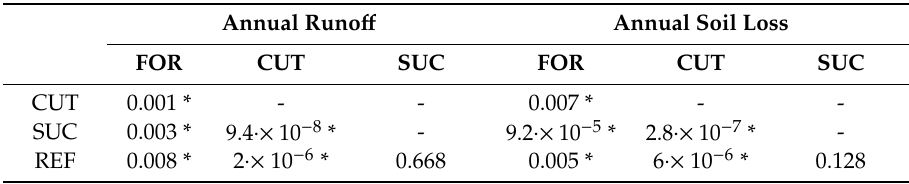
Table 12. U-test p -values for standardized annual modeling results, (FOR)ested, (CUT)-down, (SUC)CESSION and (REF)orested samples.